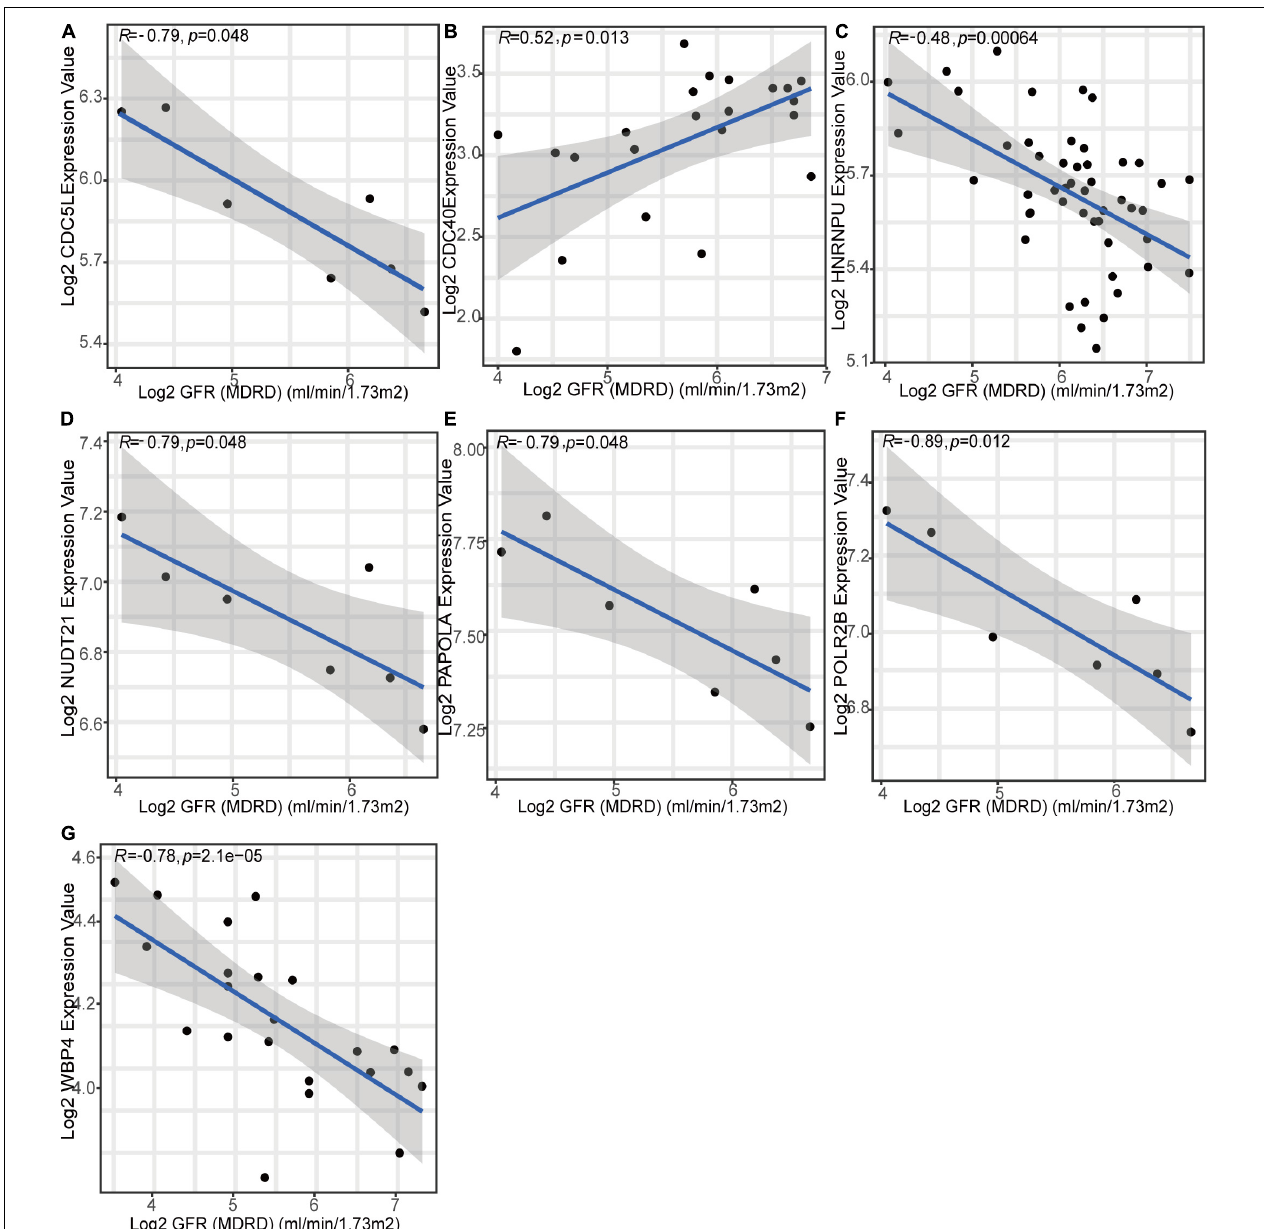
FIGURE 8 | Relationship between seven m 6 A methylation pattern markers and renal function (glomerular filtration